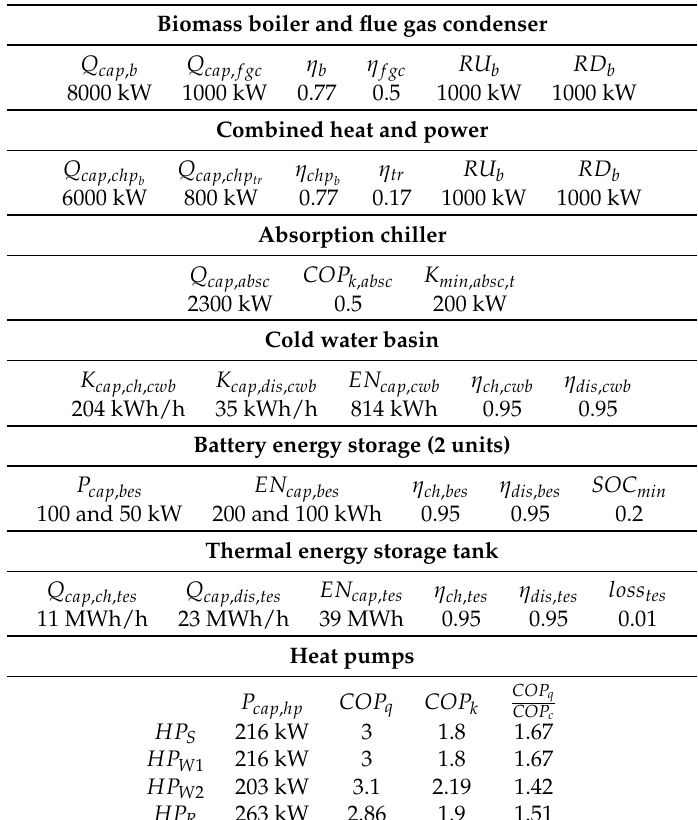
Table A1. Technology characteristics.